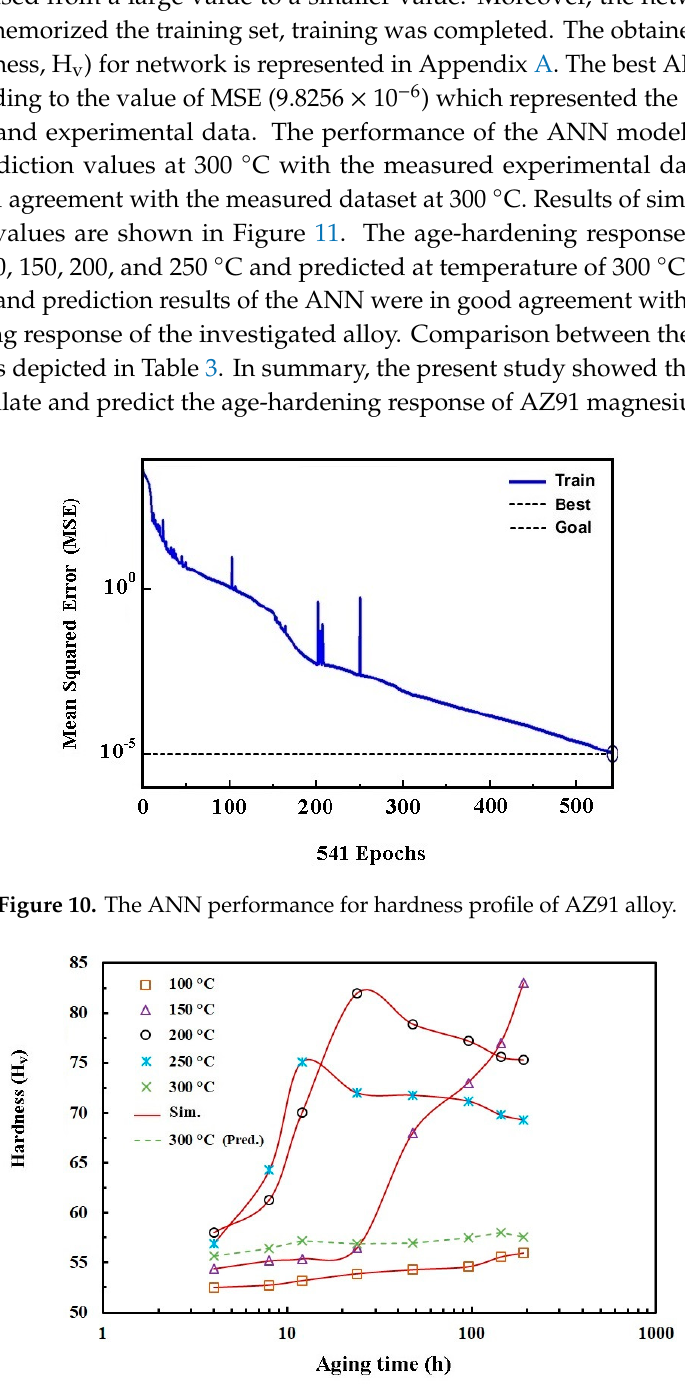
Figure 11. Simulation and prediction of the hardness profile based ANN model. Table 3. Comparison between the ANN results and experimental data.